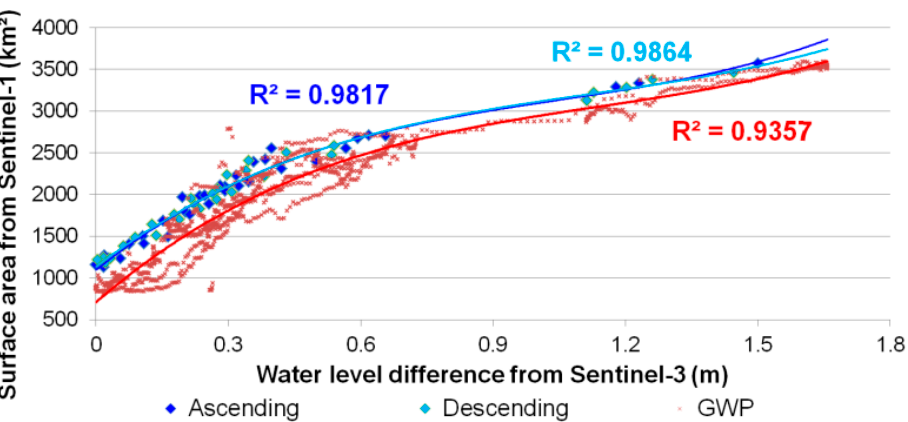
Figure 6. The hypsometry of Lake Urmia estimated by fitting the surface area detected by ascending and descending Sentinel-1 SAR imagery and the Global WaterPack (GWP) product with the water level estimated by Sentinel-3 altimetry using third-order polynomial functions.